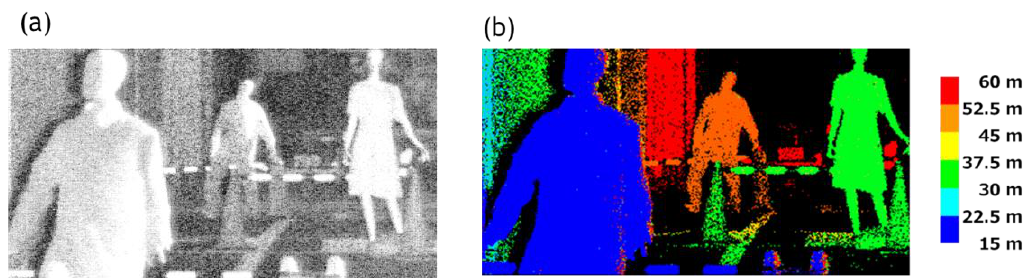
Figure 17. An intensity image ( a ) and a depth map ( b ) taken during daytime under a sunlight condition. The full range is 60 m and each subrange is set as 7.5 m. Pedestrians from near range to 50 m range are clearly recognizable.